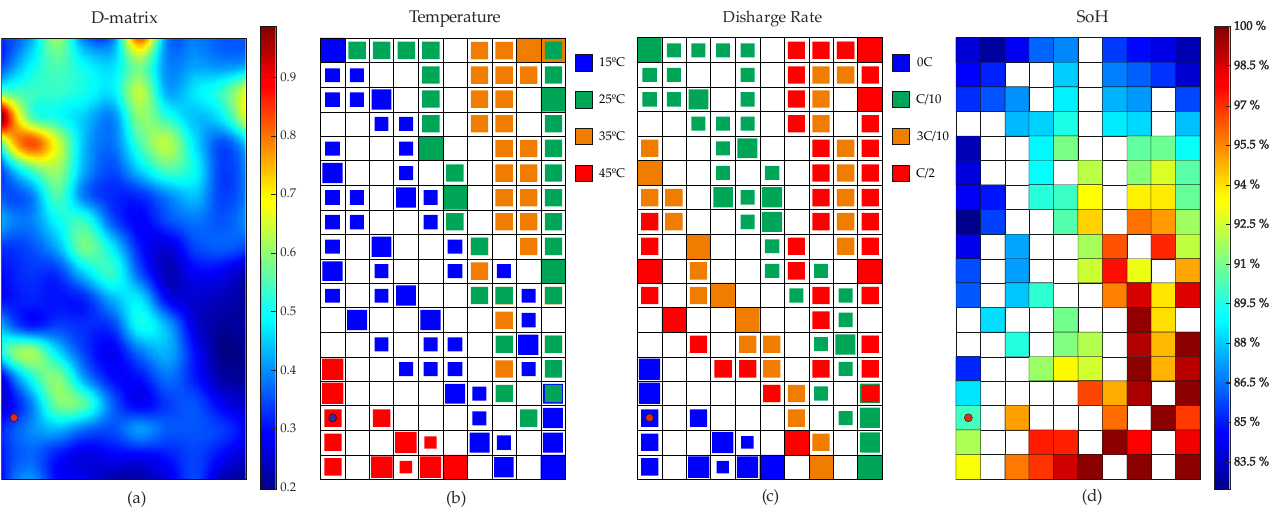
Figure 15. Cell 13 trajectory with different labels to analyze its path on the map. ( a ) Temperature distribution map; ( b ) Maximum charge voltage map; ( c ) Charge current rate distribution; ( d ) Discharge current rate distribution.